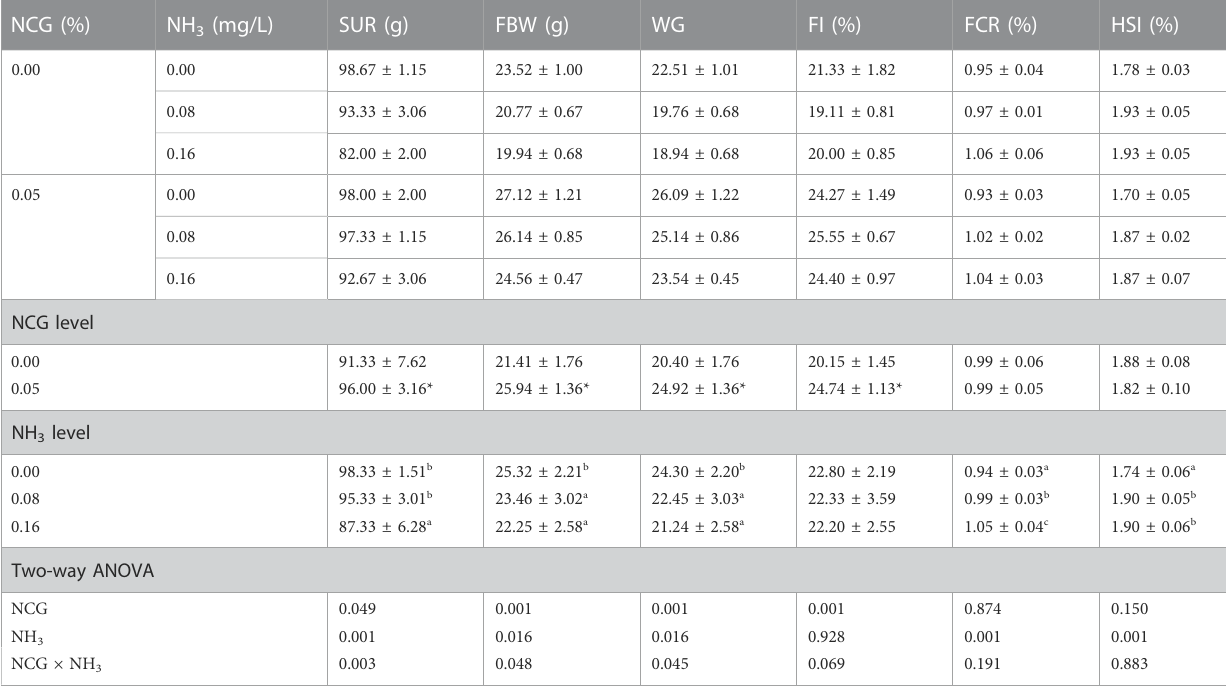
TABLE 3 Effects of dietary N -carbamylglutamate supplementation on growth performance of yellow cat fi sh exposed to different ammonia levels for 84